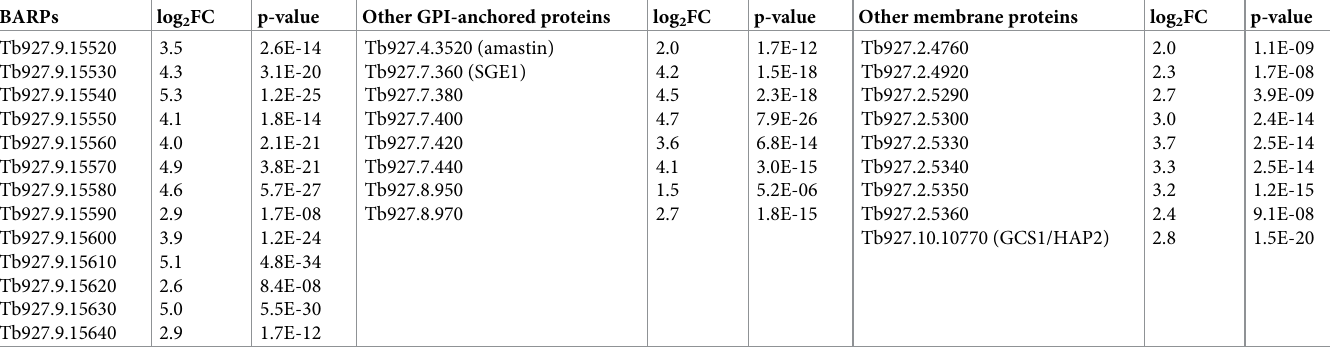
Table 1. Surface protein transcripts, in addition to mVSGs, specifically upregulated in the salivary glands. BARPs